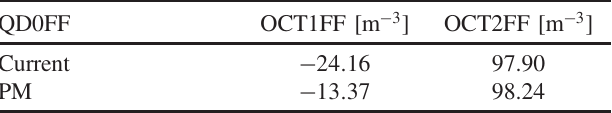
TABLE V. Integrated strength for the octupole magnets OCT1FF and OCT2FF when considering two different QD0FF magnets, the installed quadrupole and the PM